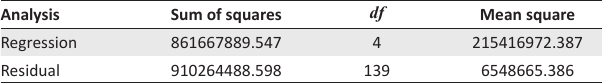
TABLE 4: Analysis of variance – Fixed pay.